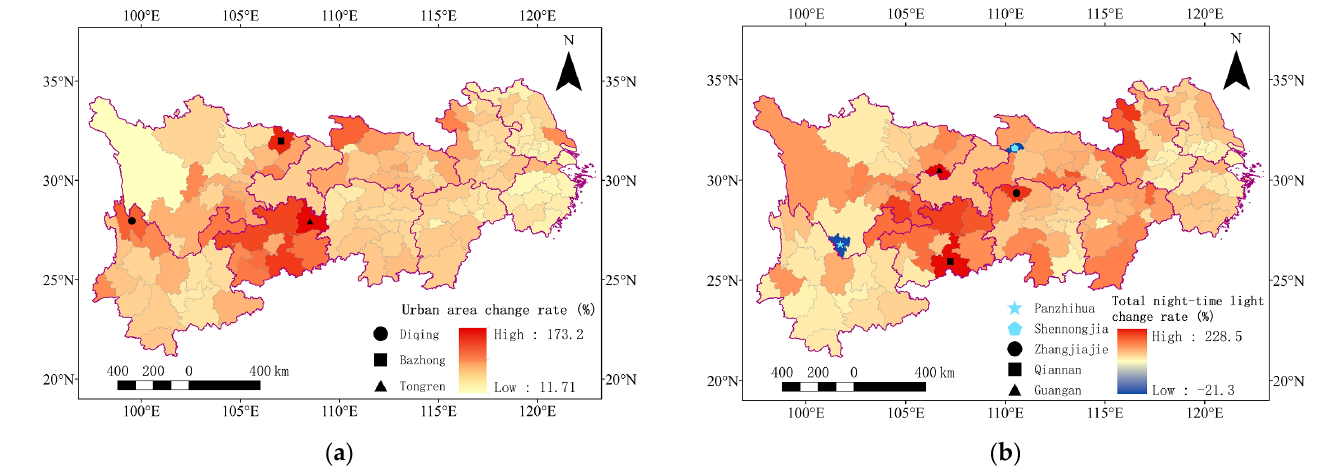
Figure 8. The urban growth rate during 2012–2019: ( a ) urban area; ( b ) total night-time light. Table 3. Growth rates ( r ) of urban area of cities in the three reaches.